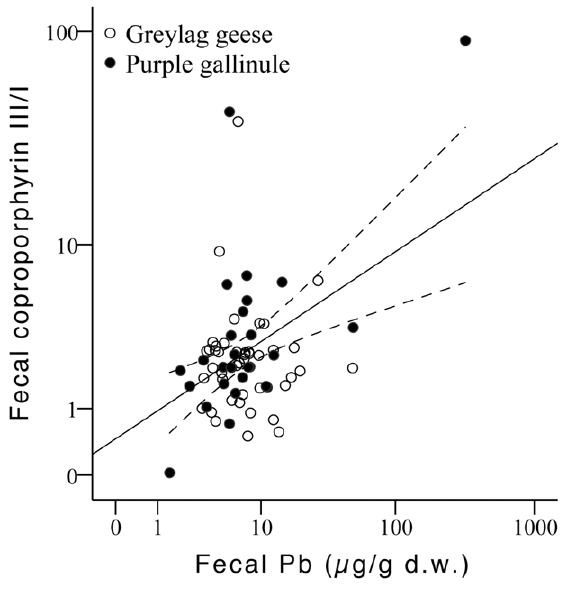
Figure 7. Relationship between Pb concentration and the coproporphyrin III/I ratio in fecal samples from greylag geese and purple gallinule collected in Don˜ana (r=0.420 p , 0.001, n=71; independently for each species r=0.007 p . 0.05, n=44; r = 0.636 p , 0.001, n= 27; for greylag geese and purple gallinule,